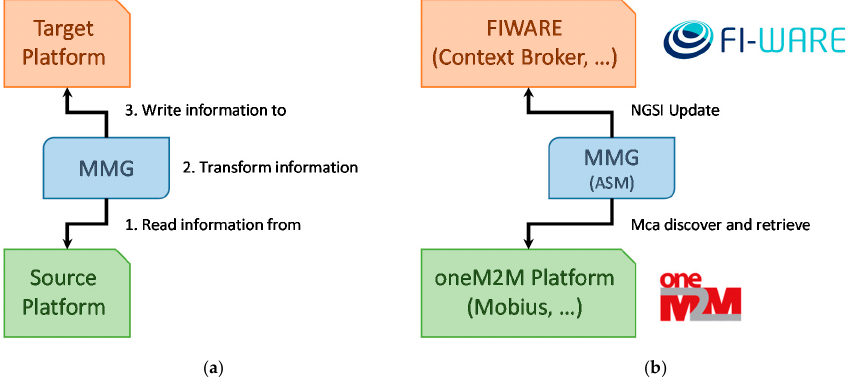
Figure 2. Abstract architecture of the MMG ( a ) and example of an MMG instantiation ( b ).